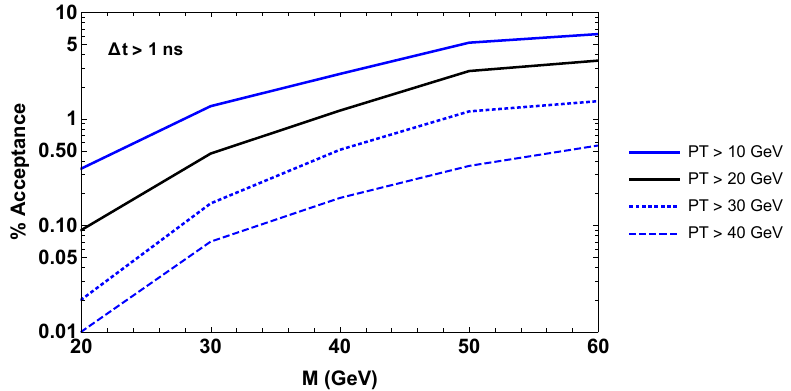
Figure 6 . Acceptance as a function of right-handed neutrino mass for a decay length, c(cid:28) = 1 m for Ecal timing based